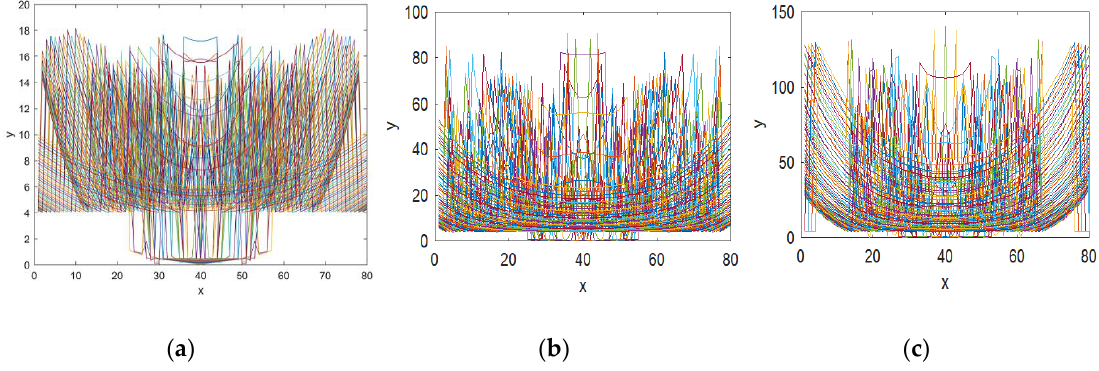
Figure 4. Fractal image trajectory map generated from : ( a ) MS function; ( b ) CFF with 𝛽 = 0.3; ( c ) CFF with 𝛽 = 0.5.